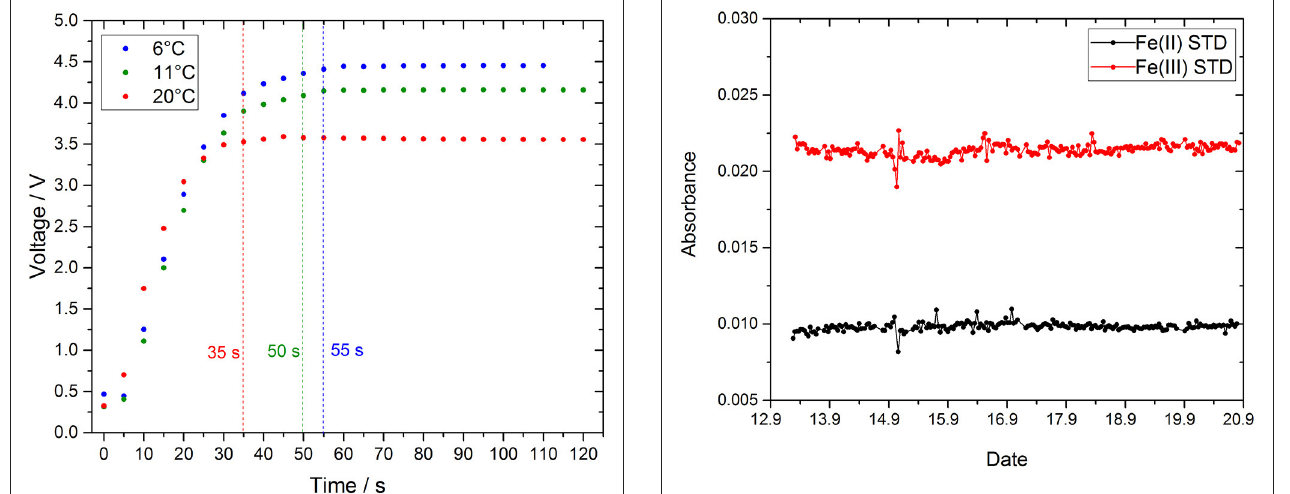
FIGURE 5 | Stability of two Fe standard solutions, 50nM Fe(II) (black line) and 100nM Fe(III) (red line) over the duration of the nine day deployment in Kiel